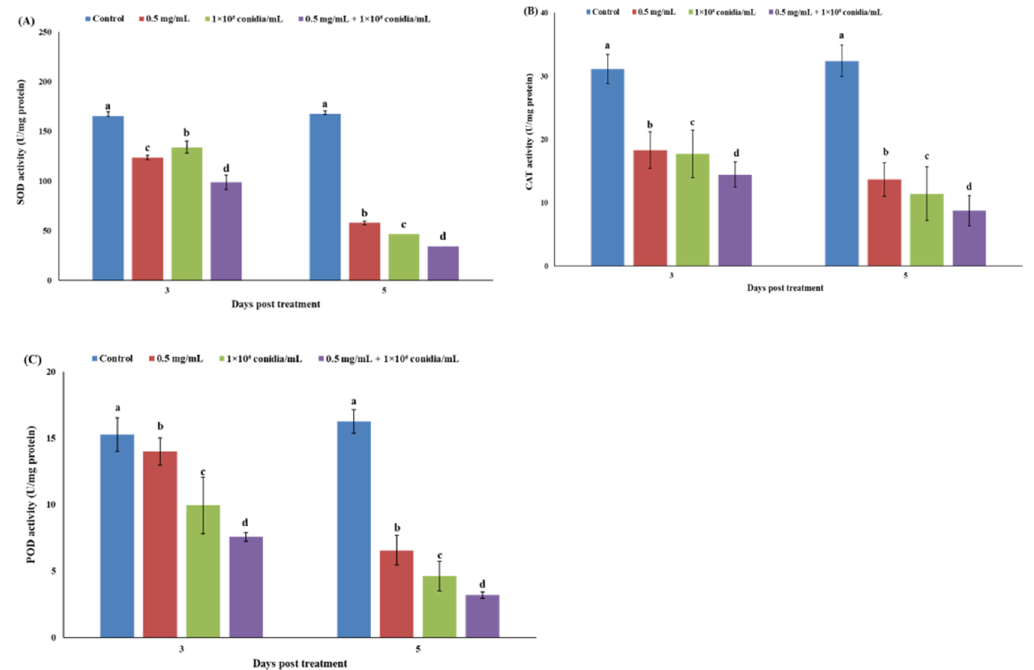
Figure 5. Changes in antioxidant enzyme activities of M. usitatus following single or joint treatments of A. attenuatus and matrine after 3 and 5 days of treatment. ( A ) Superoxide dismutase (SOD) activity; ( B ) Catalase (CAT) activity; ( C ) Peroxidase (POD) activity. Bars having different letters show significant differences between treatments at different time intervals.